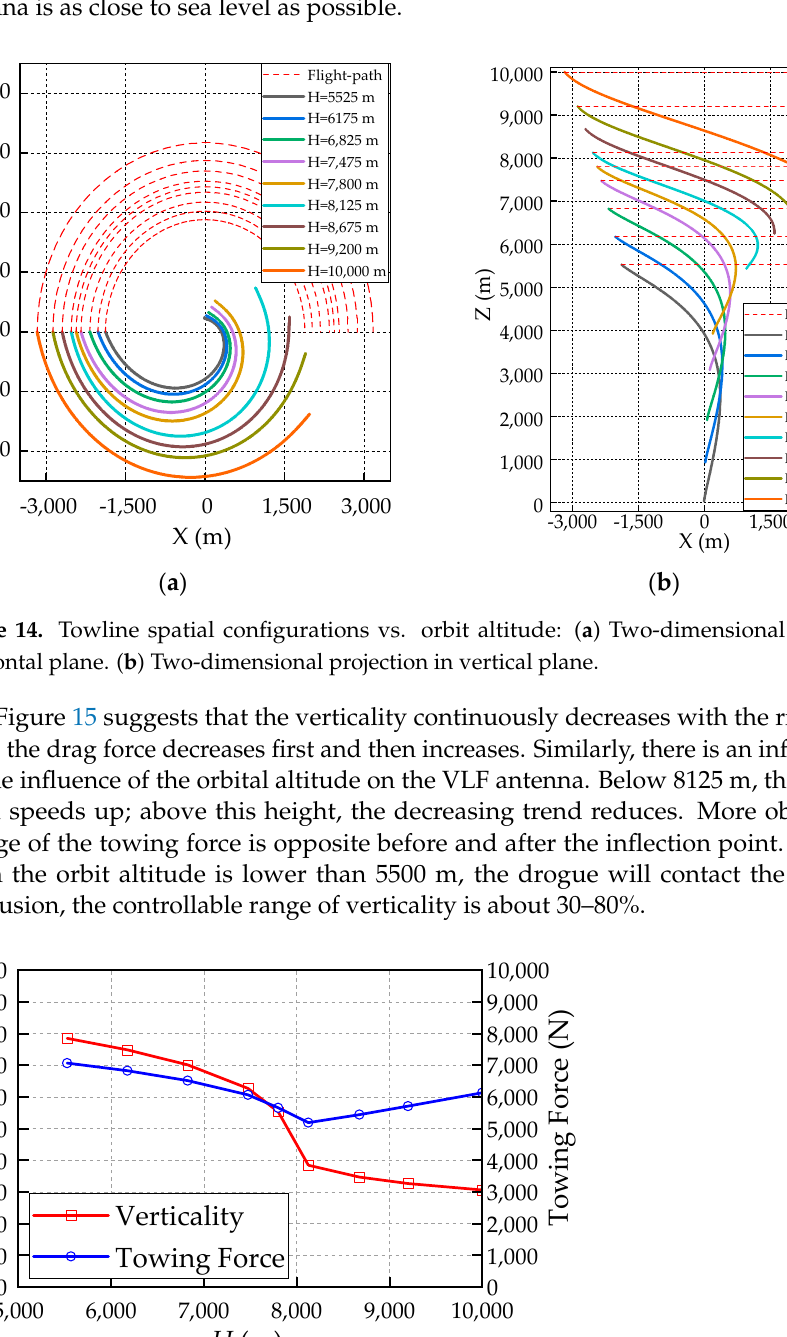
10 of 17 Figure 13. Verticality and towing force vs. towline length. 4.3. Flight Condition